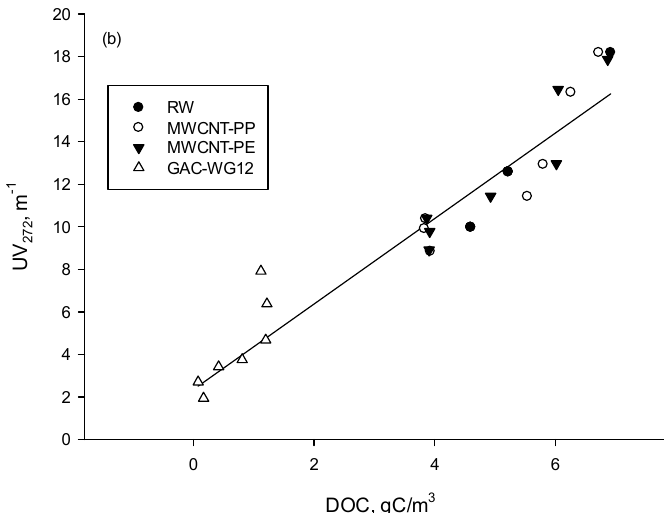
Figure 10. Relationship between ( a ) UV 254 and DOC ( b ) UV 272 and DOC.